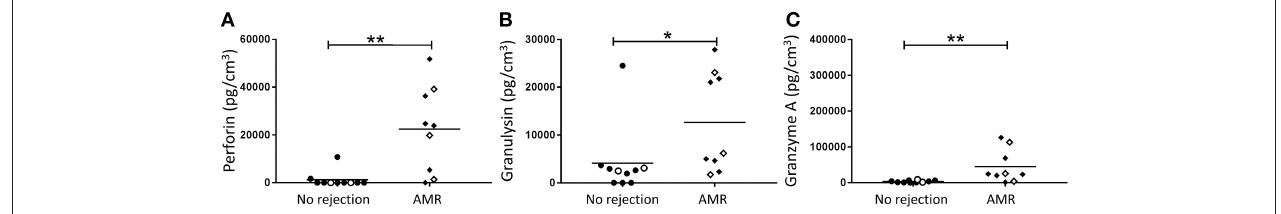
FIGURE 7 | Human kidney tissue from patients with an indication of AMR have an elevated cytotoxic effector molecule profile. Expression of (A) Perforin, (B) Granulysin, and (C) Granzyme A in transplant biopsy specimens without (no rejection; n = 10) and with AMR ( n = 9). Concentrations of effector molecules normalized to cubic centimeters of kidney tissue for individual donors are shown; donors with DSA are identified using open symbols; bars represent means. * P < 0.05, ** P < 0.01, Mann-Whitney